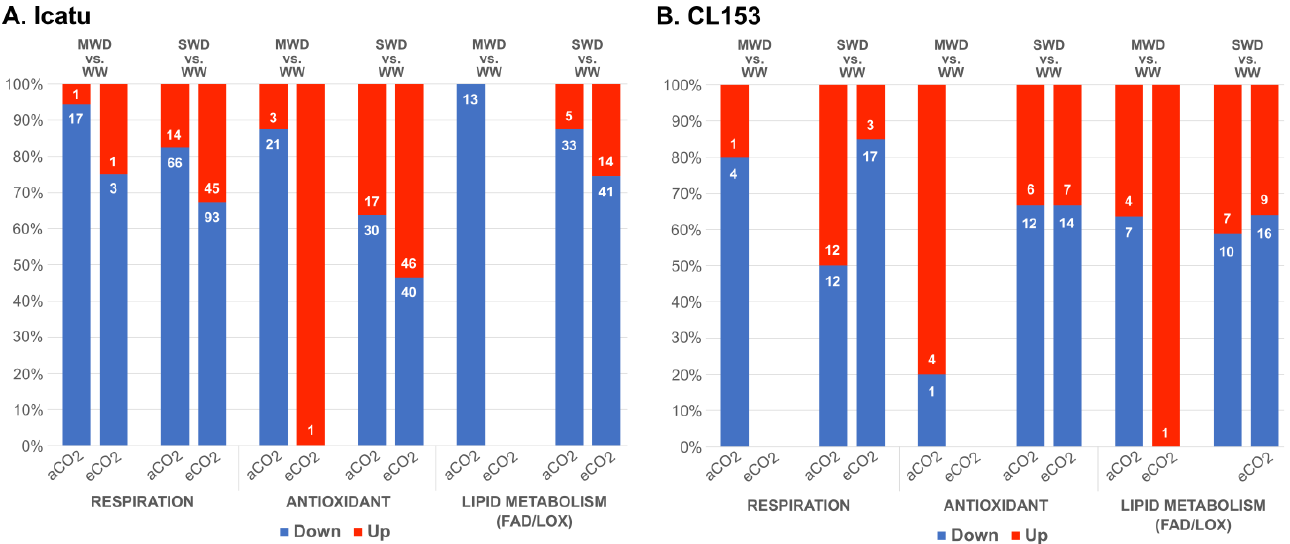
Figure 3. Proportion and number of significantly up- (red) and down-regulated (blue) DEGs associated with physiological and biochemical responses found in ( A ) Icatu and ( B ) CL153 plants grown under MWD or SWD in comparison with WW plants grown under aCO 2 or eCO 2 , at 25/20 °C (day/night).